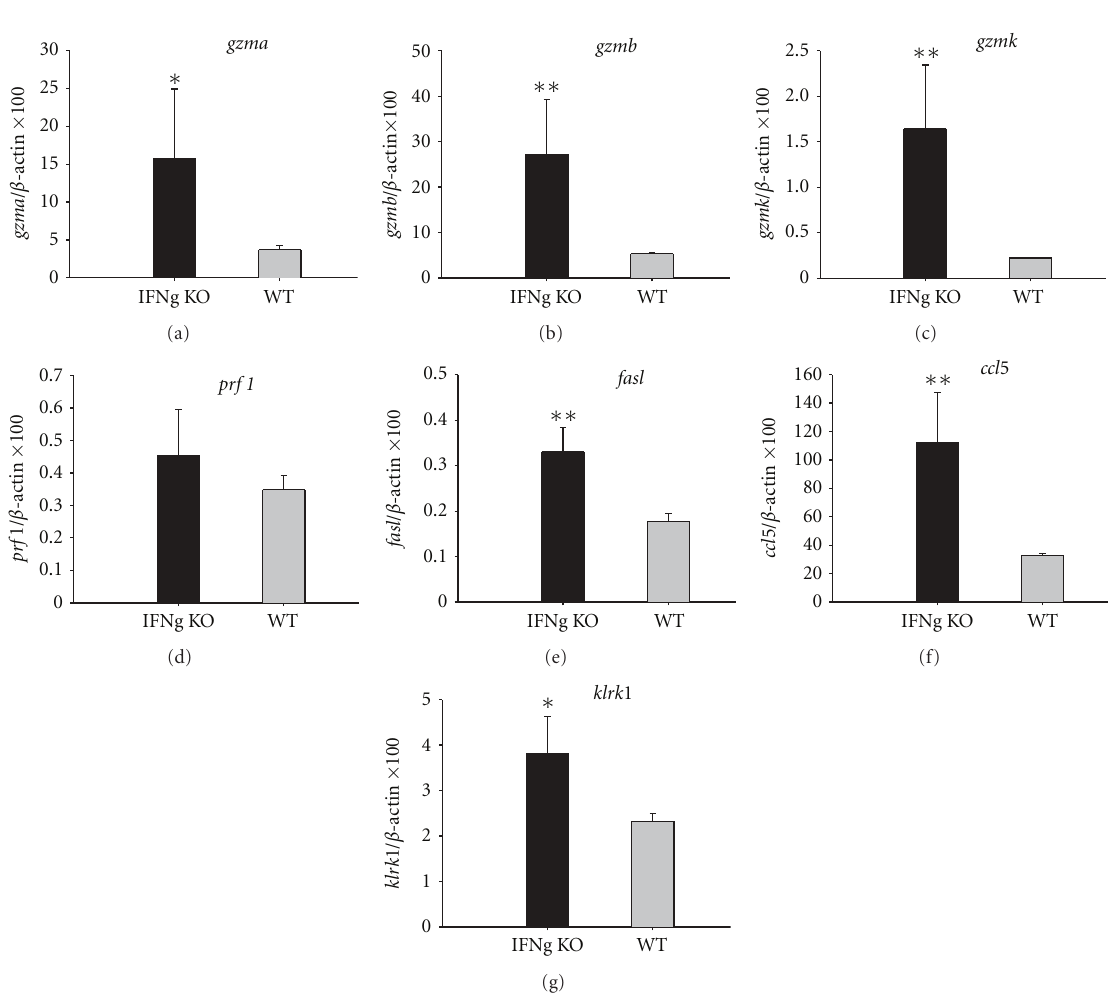
Figure 6: Relative transcription levels of gzma , gzmb , gzmk , prf1 , fasl , ccl5, and klrk1 in splenocytes of Schistosoma japonicum -infected IFNg KO and WT mice by real-time PCR. Data were analyzed using the Mann-Whitney test for statistical support (compared with WT mice, ∗ P < 0 . 05, ∗∗ P < 0 .